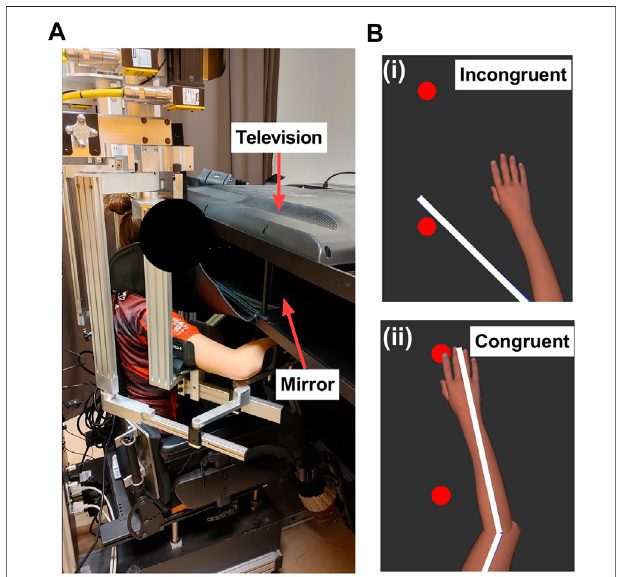
FIGURE 1 | Experimental set up. (A) : The KINARM is a robotized exoskeleton allowing upper limbs movement in the horizontal plane. A 2D virtual environment is interfaced with the robot allowing to project a virtual upper limb that is moving either in a congruent or incongruent manner relative to the actual upper limb movement of the participant. In order to have anappropriatevisionofdepthofthevirtualupperlimb,amirrorispositionedat halfway between the actual upper limb and the television. (B) : The virtual upper limb moving either in incongruent (i) or incongruent manner (ii) . The white lines depict the actual position of the upper